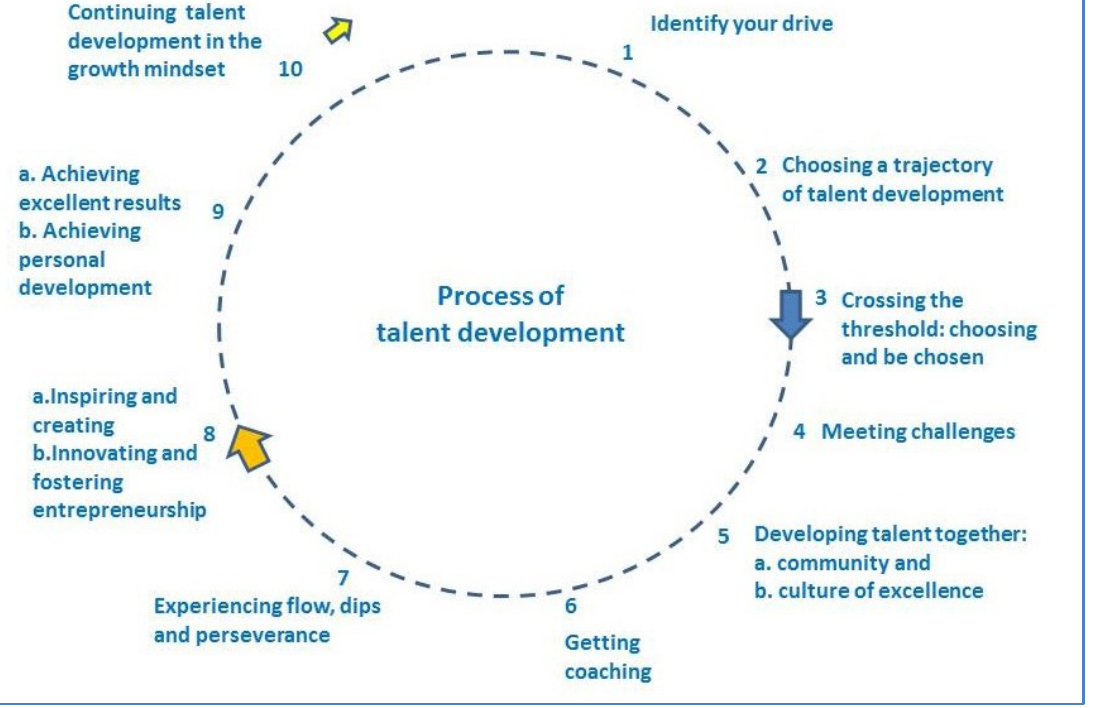
We also identified ideas and tips for talent development in honours programmes and other programmes. A series of similarities of honours experiences with 21st century skills were